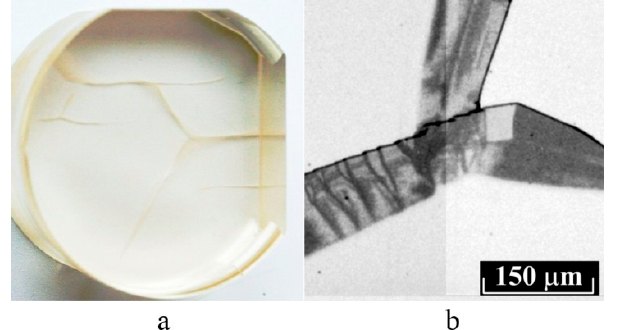
Figure A1. Cracking in heavily doped LiNbO 3 crystals: ( a )–LiNbO 3 :Mg ([MgO] ≈ 4 mol% in the crystal); ( b )–LiNbO 3 :Zn (direct doping, [ZnO] ≈ 5.19 mol% in the crystal).